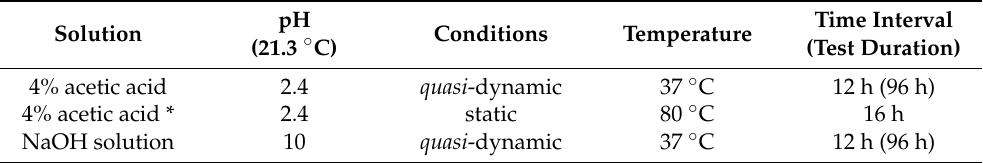
Table 1. Corrosion test